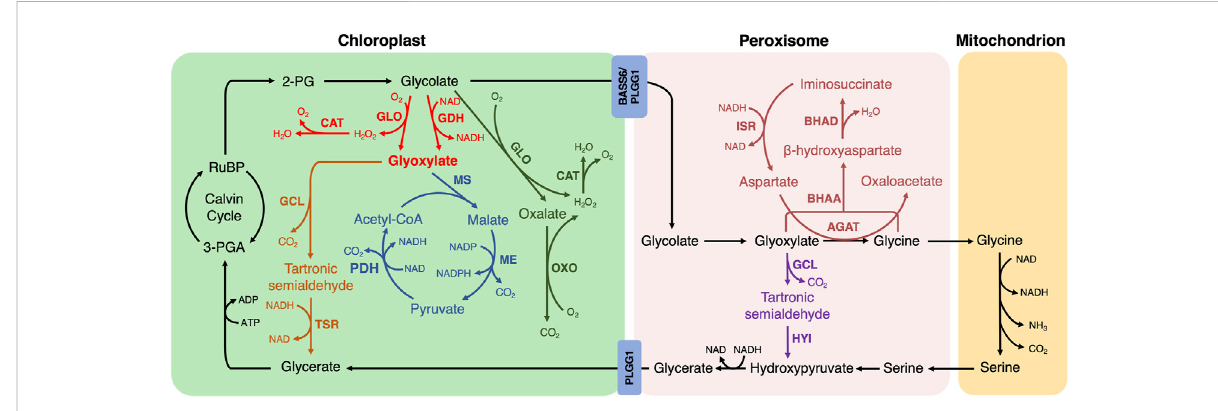
FIGURE 1 The photorespiratory bypasses implemented into plants. The natural photorespiratory pathway and biosynthetic bypasses to photorespiration are marked by de fi ned color. BASS, Bile acid sodium symporter; PLGG, glycolate-glycerate transporter. The fi rst bypass in the chloroplast (red and orange; Kebeish et al., 2007; Dalal et al., 2015; South et al., 2019; Chen et al., 2019; Wang et al., 2020; Nayak et al., 2022; Zhang et al., 2022): GLO, glycolate oxidase; CAT, catalase; GDH, glycolate dehydrogenase; GCL, glyoxylate carboligase; TSR, tartronic semialdehyde reductase. The second bypass in the chloroplast (red and blue;Maier et al., 2012; South et al., 2019; Cavanagh et al., 2022): MS, malate synthase; ME, malic enzyme; PDH,pyruvatedehydrogenase.Thethirdbypassinthechloroplast(green;Shenetal.,2019):OXO,oxalateoxidase.The fi rstbypassintheperoxisome (purple; Carvalho et al., 2011): HYI, hydroxypyruvate isomerase. The second bypass in the peroxisome (dark red; Roell et al., 2021): AGAT, aspartate: glyoxylate aminotransferase; BHAA, β -hydroxyaspartate aldolase; BHAD, β -hydroxyaspartate dehydratase; ISR, iminosuccinate